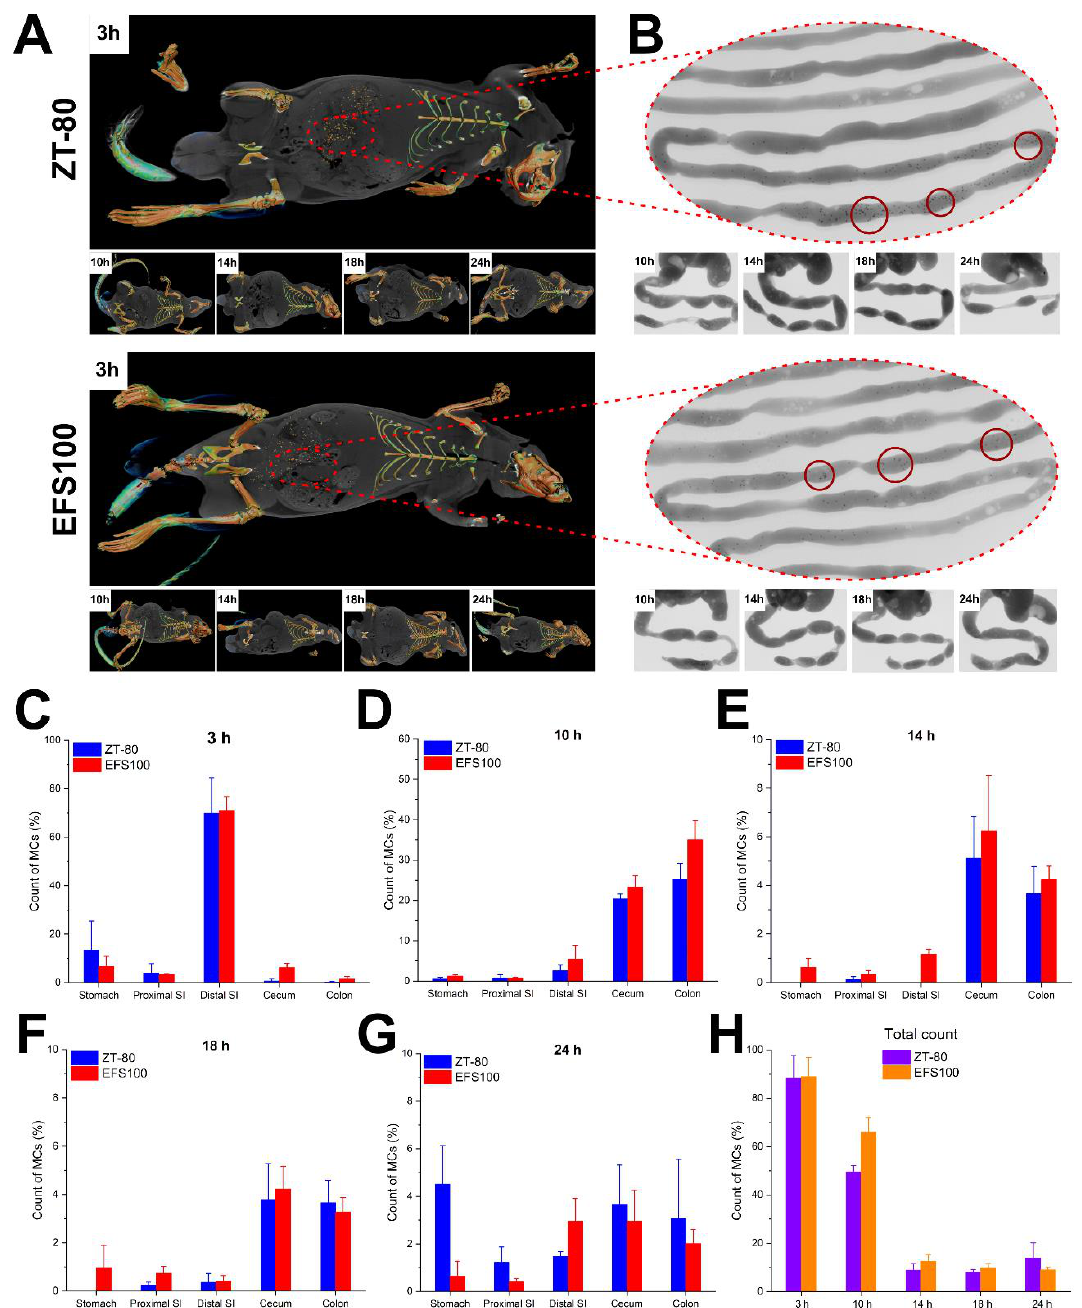
Figure 5. ( A ) Representative CT scan images of rats with ZT-80- and EFS100-coated MCs loaded with BaSO4. ( B ) Representative planar X-ray images of the intestines of rats. Red circles emphasize the areas with clusters of MCs. ( C – G ) Count of visualized MCs coated with either ZT-80 or EFS100 at different time points and the various sections of the rat GIT. ( H ) The total count of the MCs visualized inside the body of rats at different time points. Data are presented as mean ± SD, n = 3.